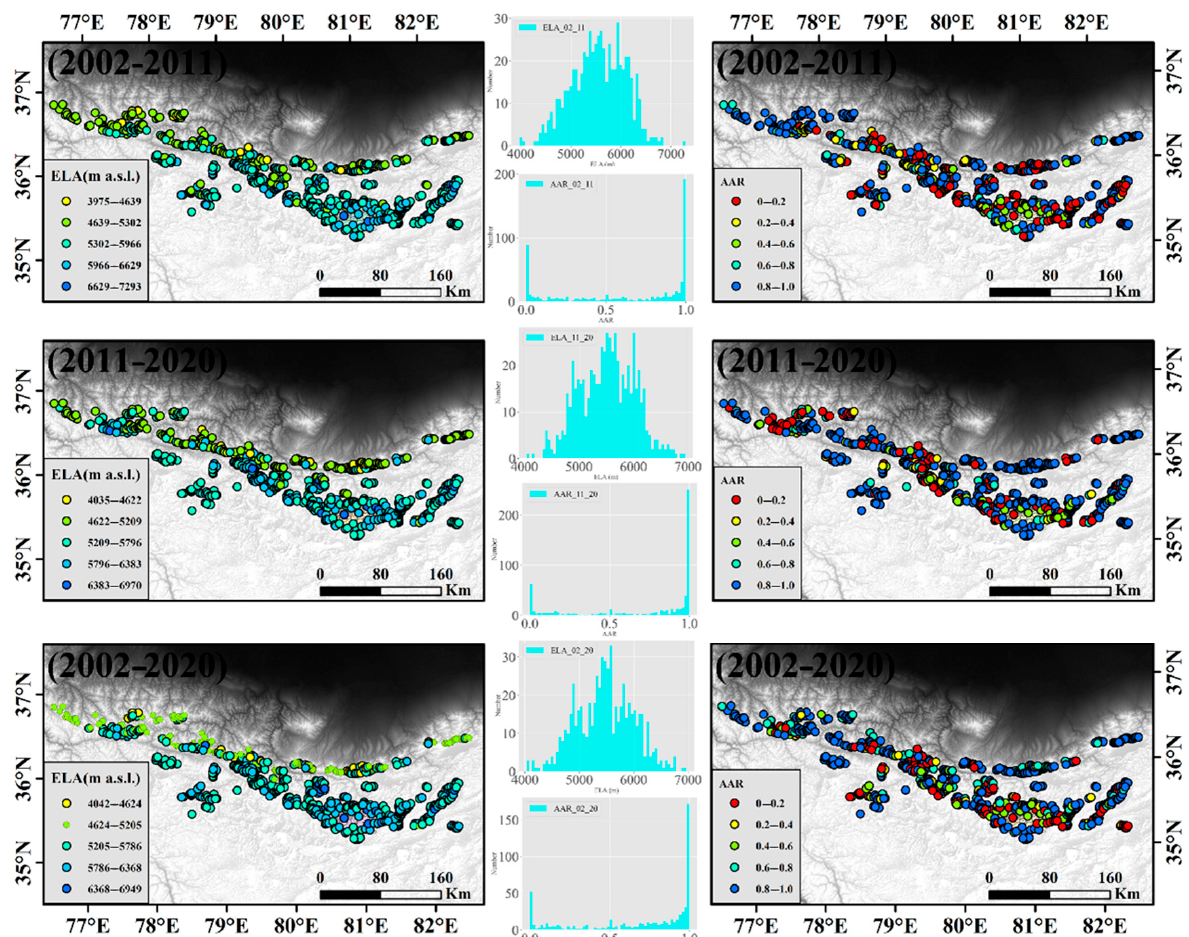
Figure 5. Equilibrium line altitudes (ELAs) (left three subplots) and accumulation area ratios (AARs) (right three subplots) for each glacier in WK for three different periods; 2002–2011, 2011–2020, and